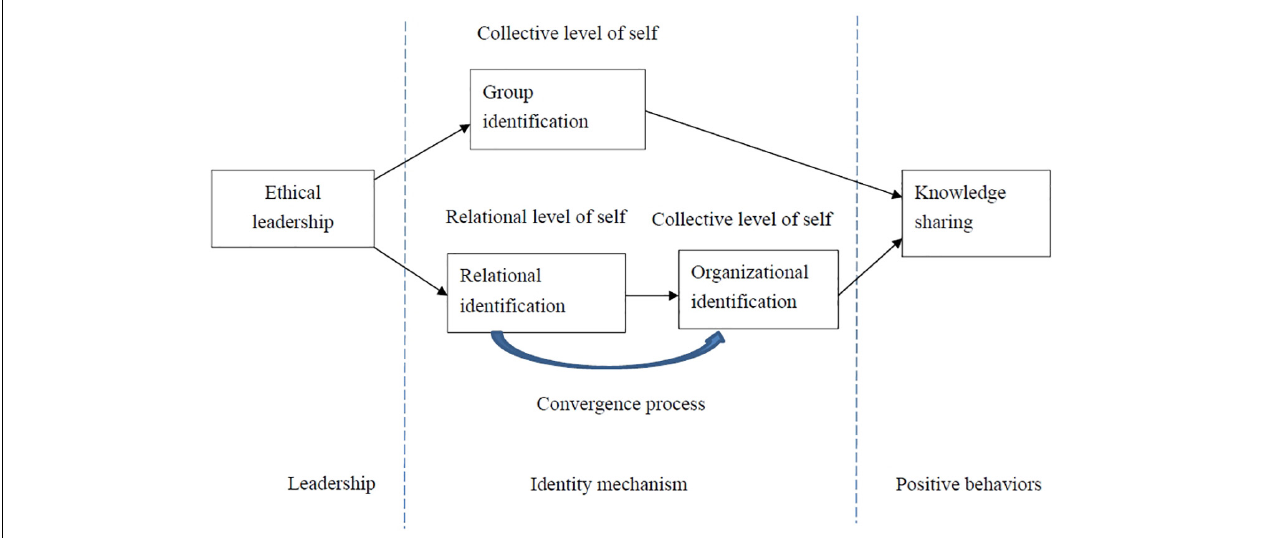
FIGURE 1 | Research